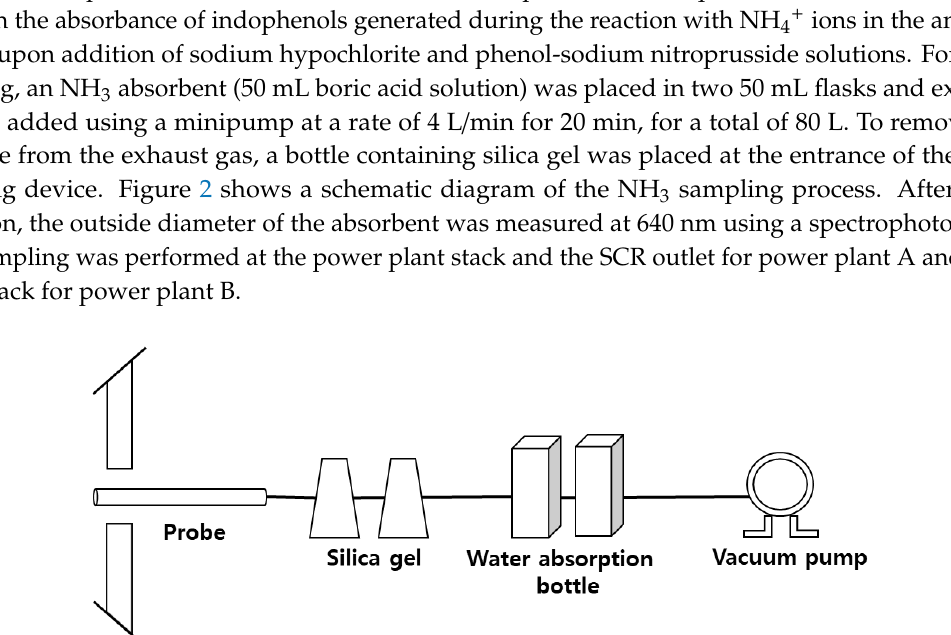
Figure 1. Schematic of the sampling point and air pollution prevention at Liquefied Natural Gas (LNG) power plants.